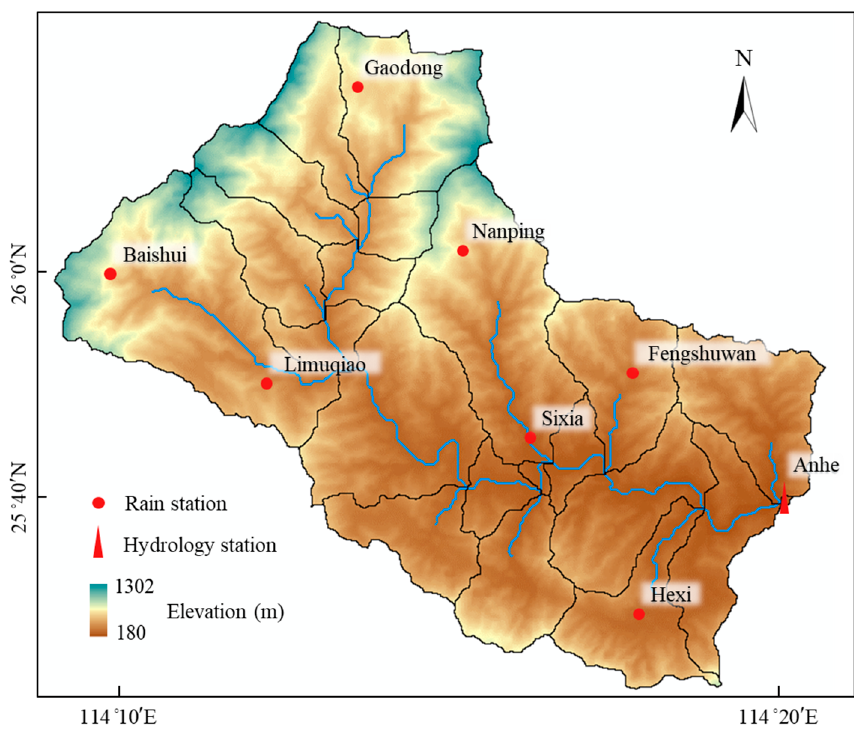
Figure 3. Schematic map of Anhe catchment, Henan, China.